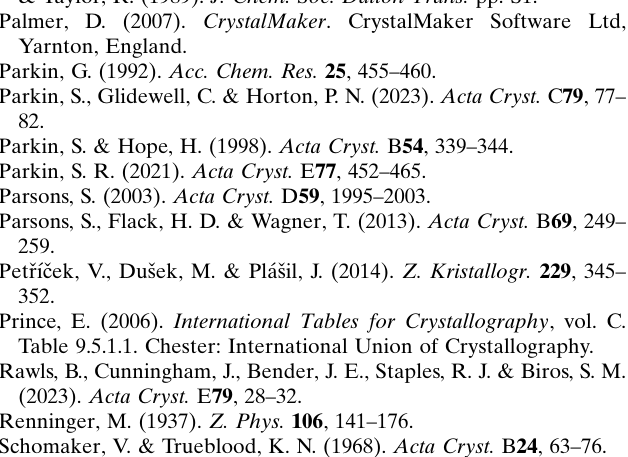
Table 9.5.1.1. Chester: International Union of Crystallography. Rawls, B., Cunningham, J., Bender, J. E., Staples, R. J. & Biros, S. M. (2023). Acta Cryst. E 79 , 28–32. Renninger, M. (1937). Z. Phys. 106 ,